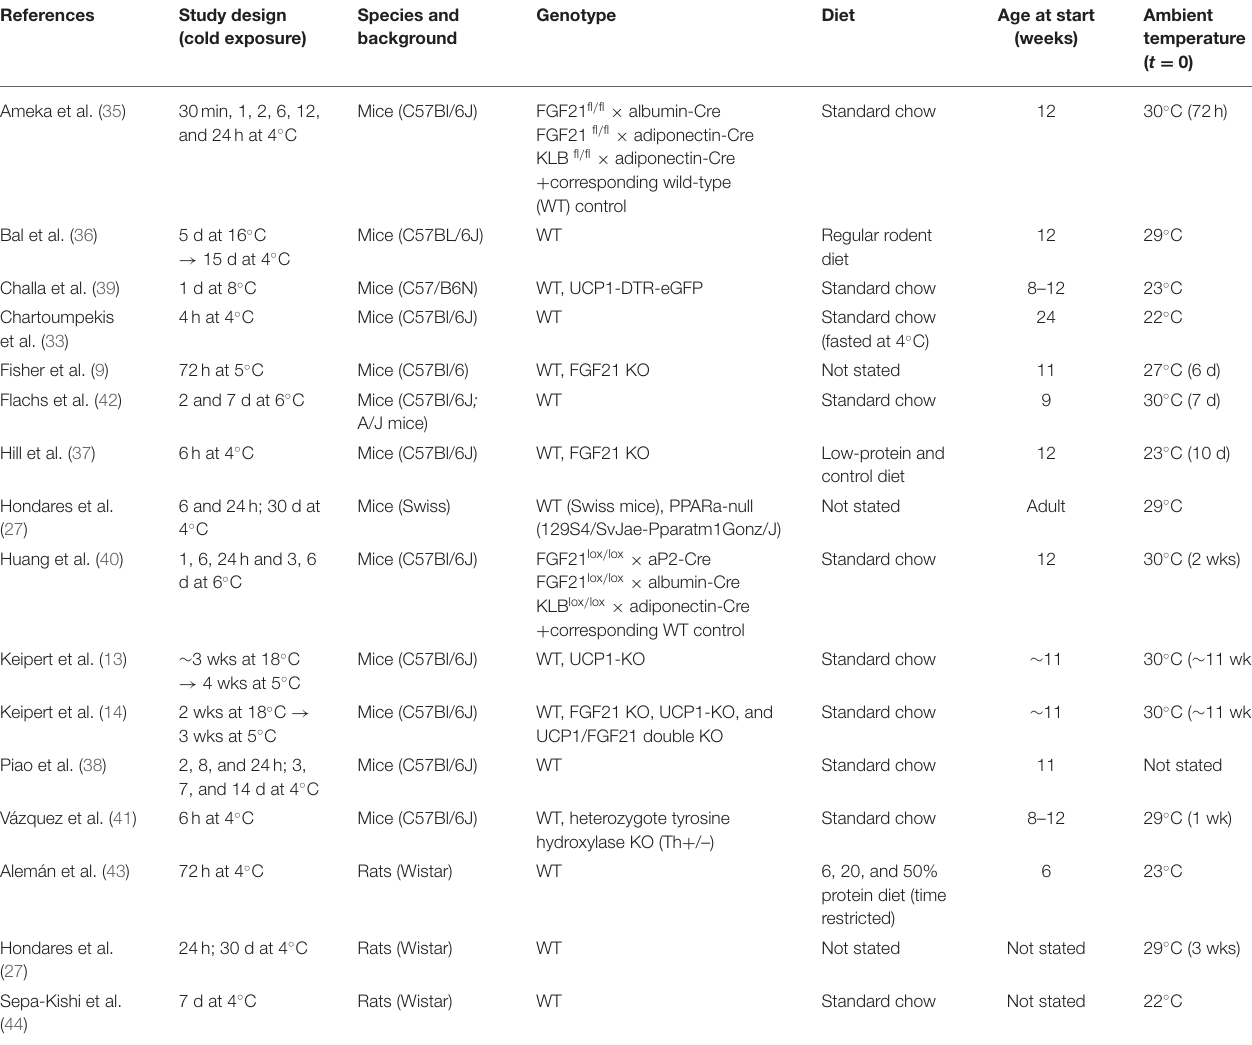
TABLE 1 | Overview of experimental designs and study specifics of publications on FGF21 and cold exposure at 4–8 ◦